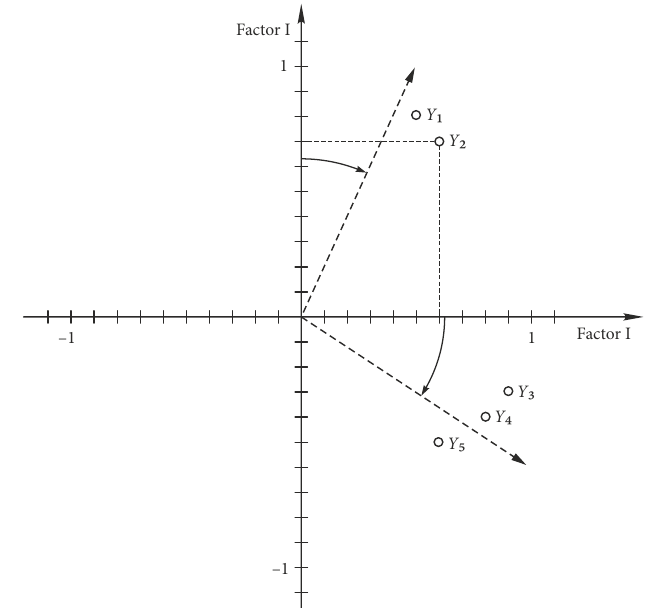
Fig. 1. Saturation of factors after Varimax rotation Note: Meloun et al. (2012), modified by